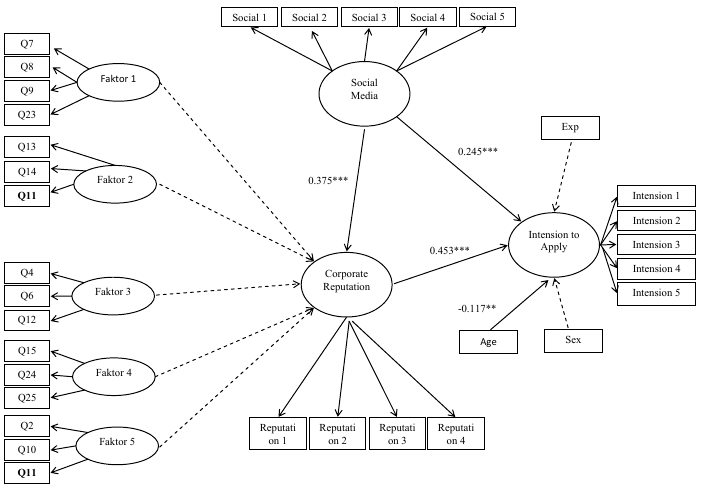
Fig. 3 – Overall results for the data set of students of economics. Source: own